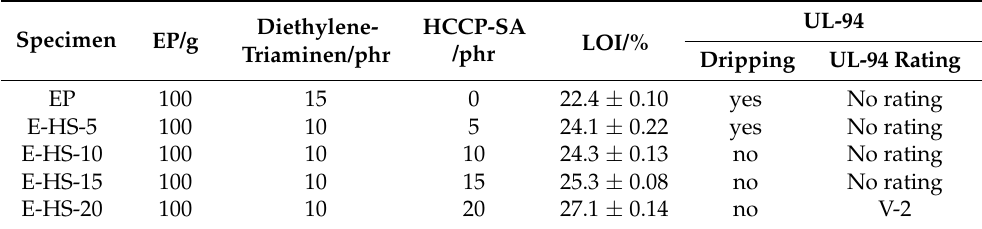
Table 1. Composition of EP and E-HS- x and flame-retardancy